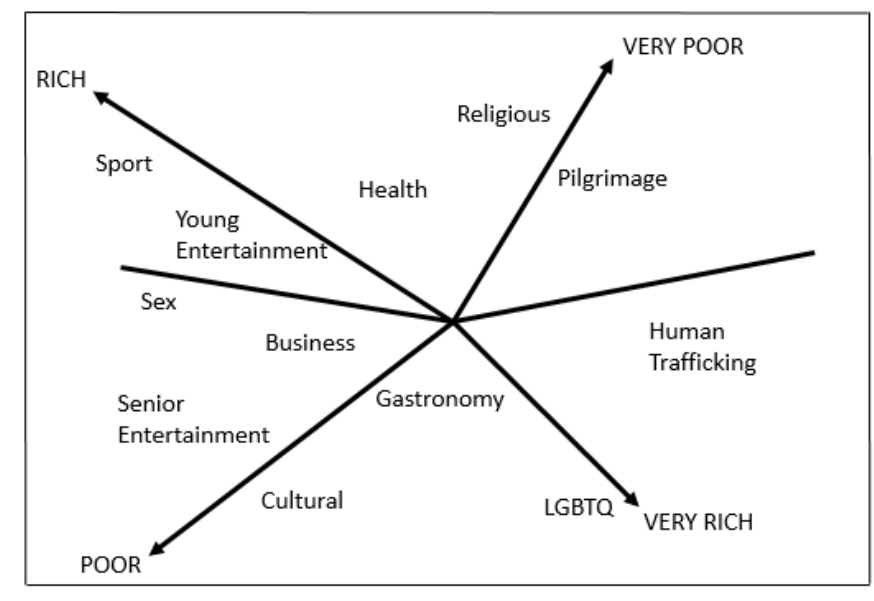
Figure 2: Tourism